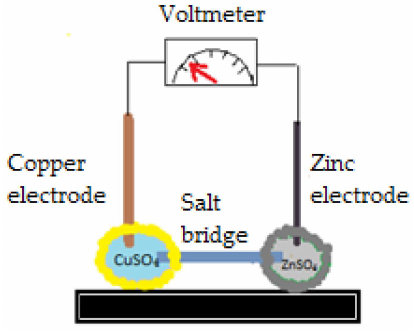
Figure 19. Liquid marbles included in a Danielle cell.